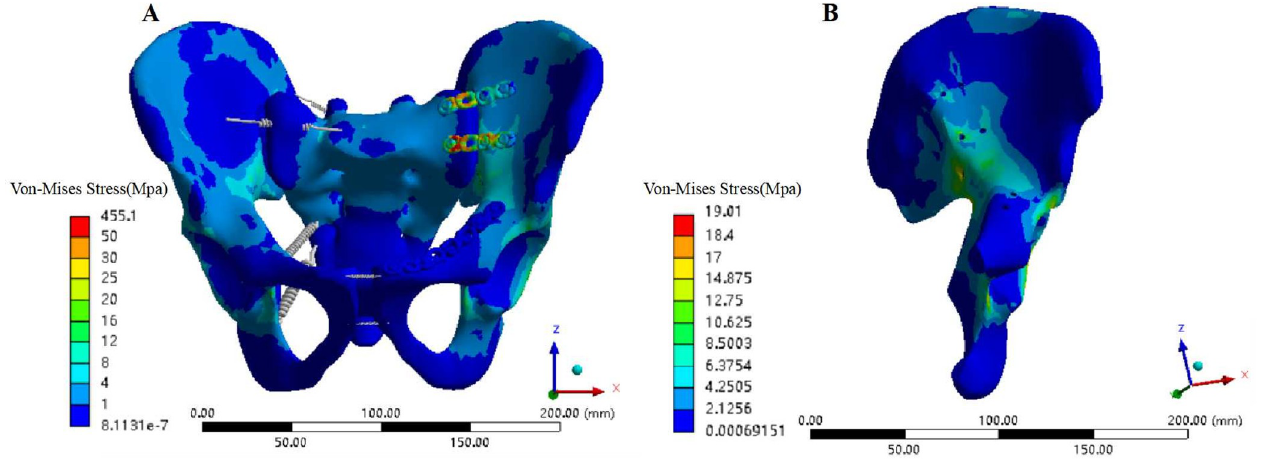
Fig 8. Von Mises stress distribution of each component of the pelvis model fixed with steel plate. (A) Von Mises stress distribution of the pelvis model fixed with a steel plate under a vertical load. (B) Von Mises stress distribution of the iliac bone of the pelvic model fixed with a steel plate under a vertical load.